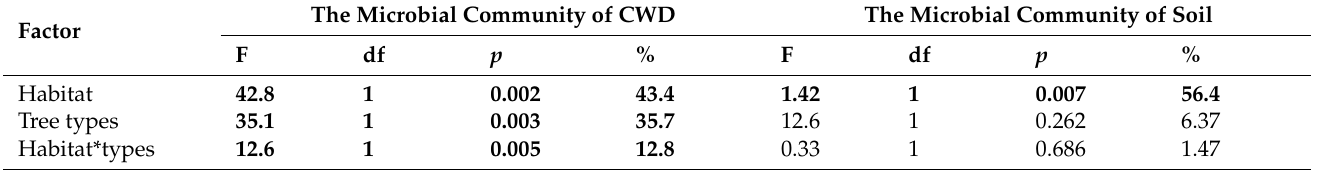
Table 4. The effect of habitat, tree types and their interactions on the microbial community compo- sition of CWD and soil was tested using PERMANOVA. Significant effects are presented in bold. % = percentage explained